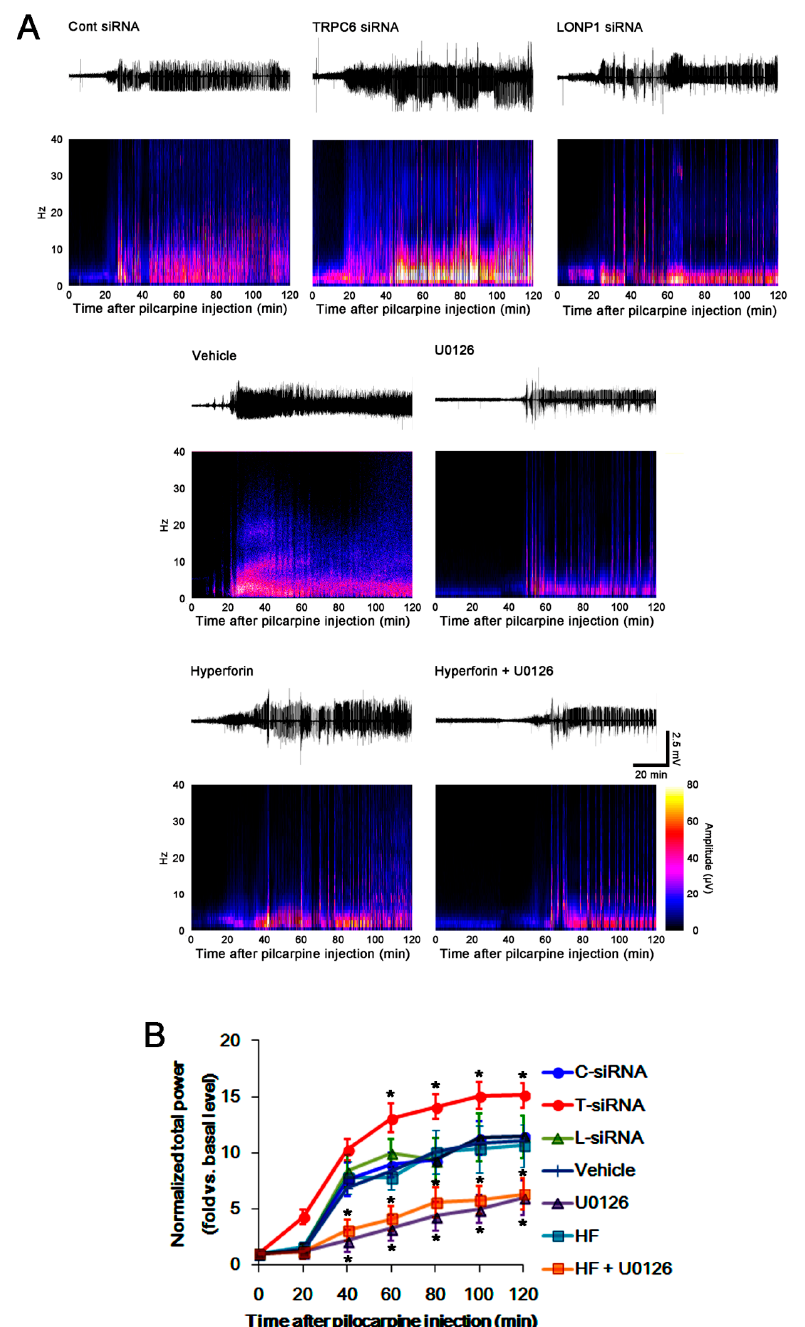
Figure 4. Effects of control siRNA, TRPC6 siRNA, LONP1 siRNA, U0126, hyperforin and co-treatment of hyperforin and U0126 on seizure activity in response to pilocarpine. As compared to control siRNA (C-siRNA), LONP1 siRNA (L-siRNA) does not affect seizure activity induced by pilocarpine. However, TRPC6 siRNA (T-siRNA) reduces seizure latency, and increases seizure severity in response to pilocarpine. No difference in seizure activity is observed between control siRNA and Vehicle (Veh)-treated animals. As compared to vehicle, hyperforin (HF) does not affect seizure activity induced by pilocarpine. However, U0126 and co-treatment of hyperforin and U0126 (HF + U0126) attenuate seizure activity in response to pilocarpine. ( A ) Representative EEG traces and frequency-power spectral temporal maps in response to pilocarpine. ( B ) Quantification of total EEG power (seizure intensity) in response to pilocarpine (mean ± S.E.M.; * p < 0.05 vs. control siRNA or vehicle; one-way repeated measure ANOVA; n = 7, respectively).